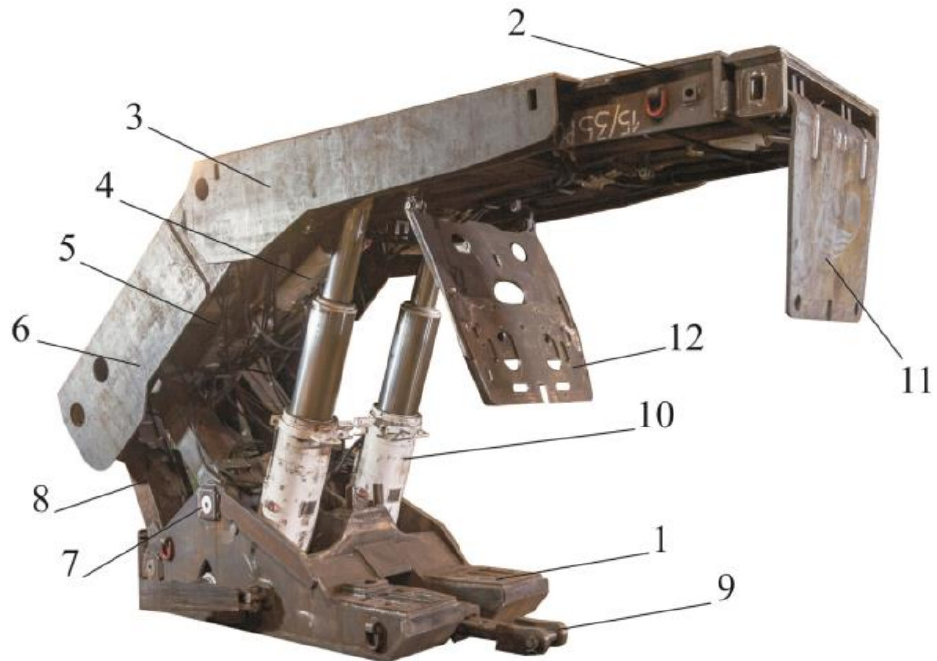
Figure 1. Longwall powered roof support, where: 1—floor base, 2—canopy, 3—lateral shield of canopy, 4—ceiling support actuator, 5—shield support, 6—lateral shield of shield support, 7—top lemniscate tie rods, 8—lower lemniscate tie rods, 9—beam of sliding system, 10—leg, 11—wall face cover, 12—crew walkway cover.